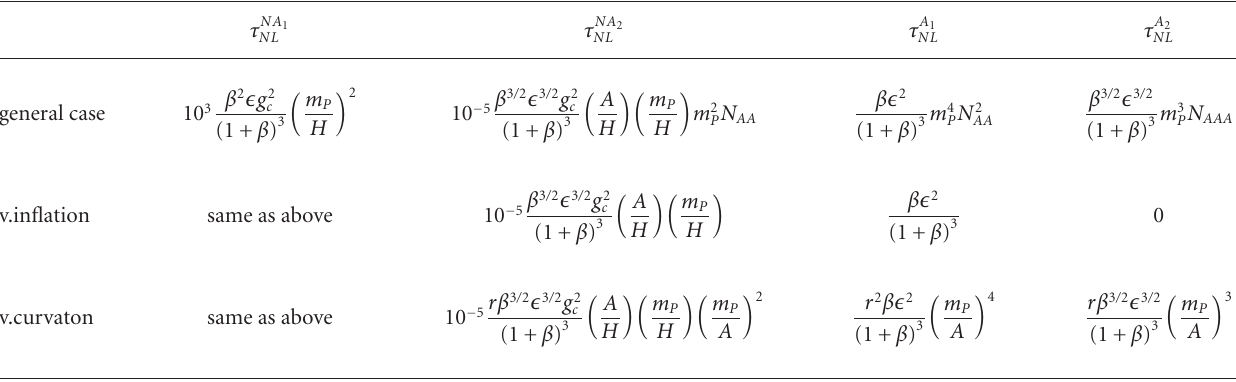
Table 3: Order of magnitude of the ratios f v